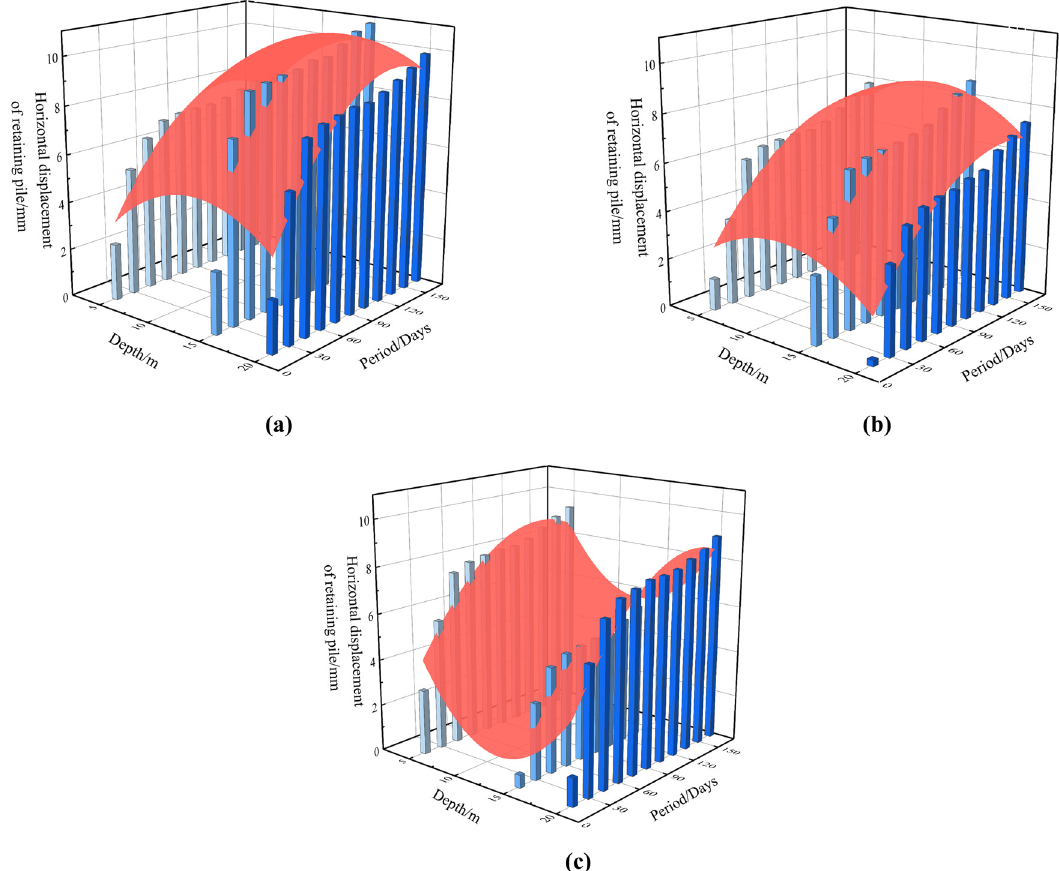
Figure 6: Horizontal displacement fi tting surface of monitoring point. ( a ) KB1, ( b ) KB2, and ( c )